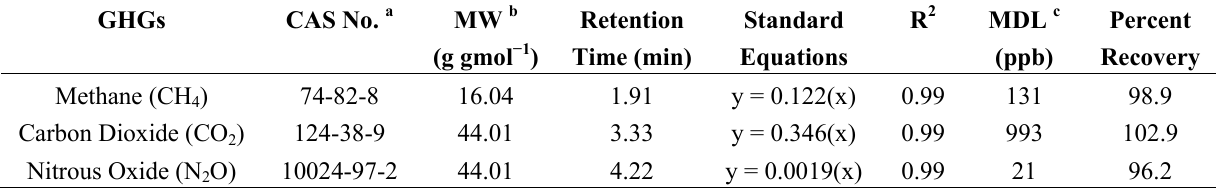
Table 1. Greenhouse gases (GHGs) quantified in this